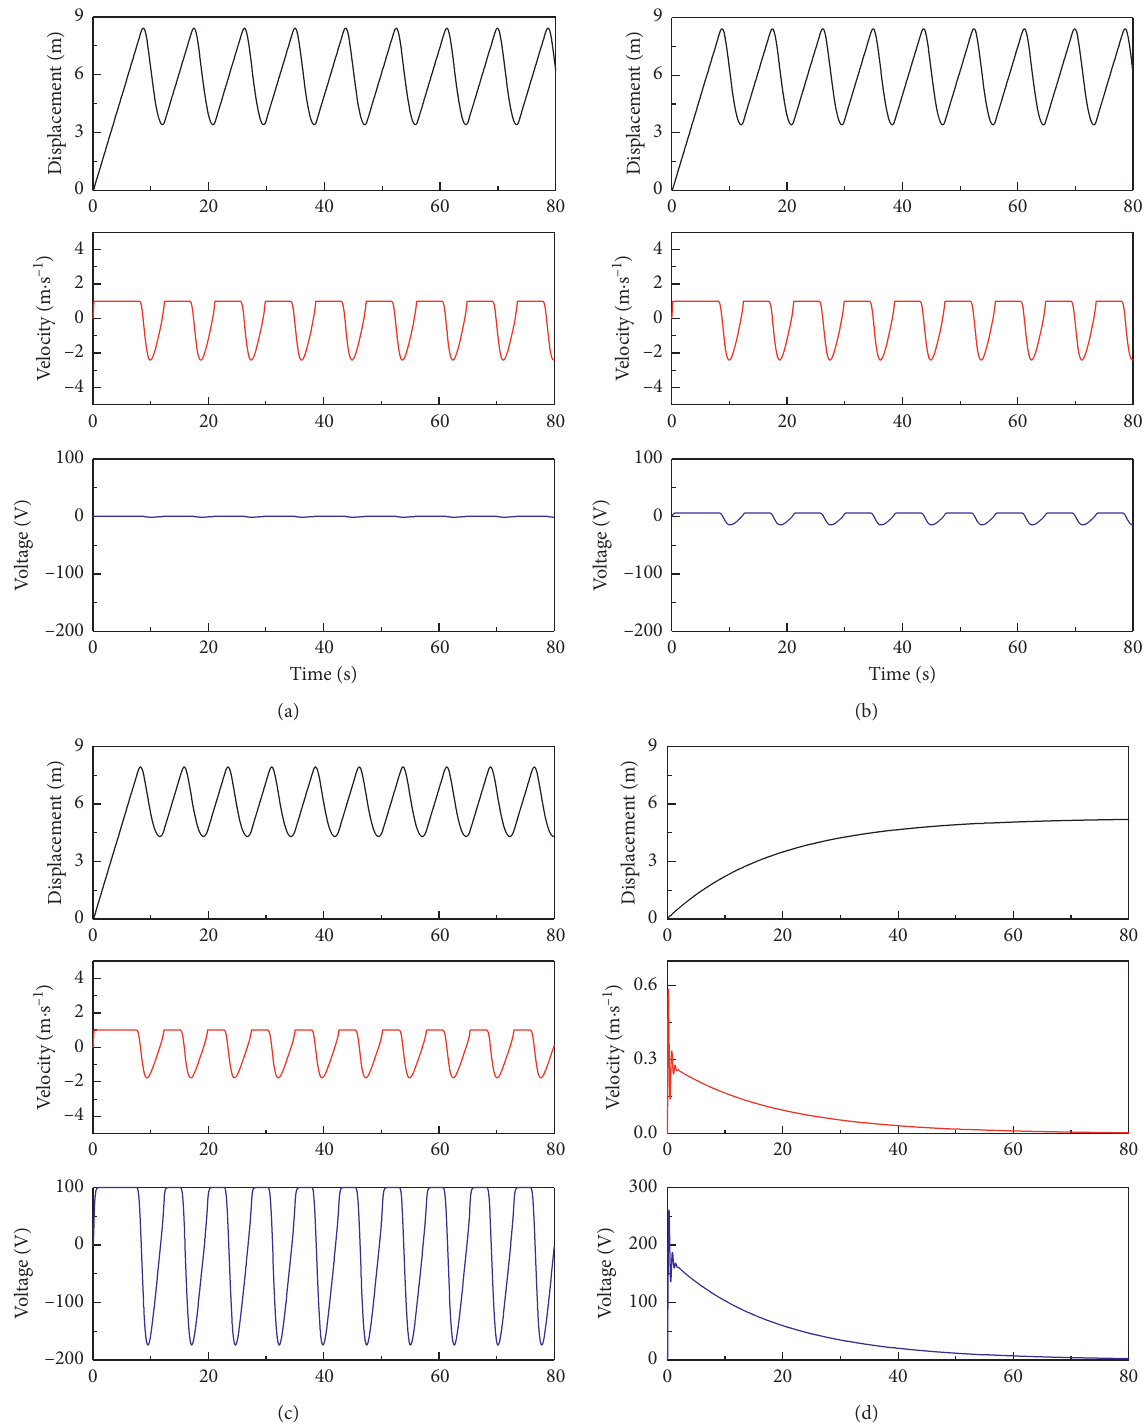
Figure 14: The displacement, velocity, and output voltage of the friction system when the force factor of piezoelectric element is α � 3.1 × 10 − 5 N/V (a), α � 3.1 × 10 − 4 N/V (b), α � 5 × 10 − 3 N/V (c), and α � 3.1 × 10 − 2 N/V (d) in the friction law